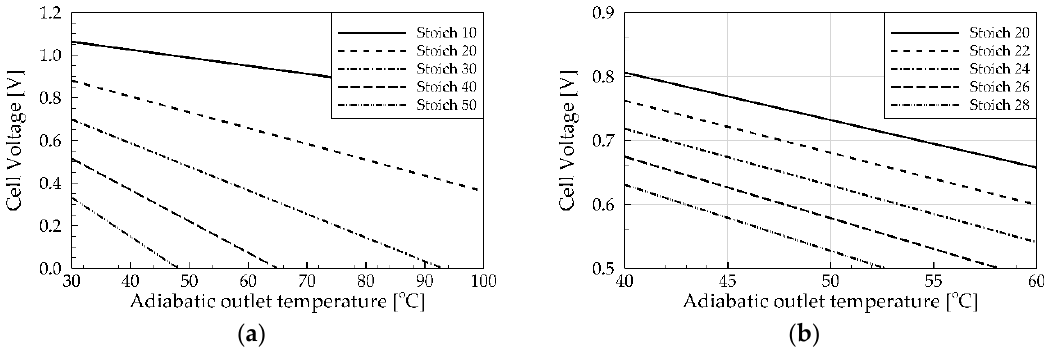
Figure 5. Dependency of the adiabatic outlet temperatures of the product stream on the operating cell voltage. The incoming conditions are a temperature of –20 ° C and a relative humidity of 0%. ( a ) Entire voltage range, ( b ) close-up on the region of interest.